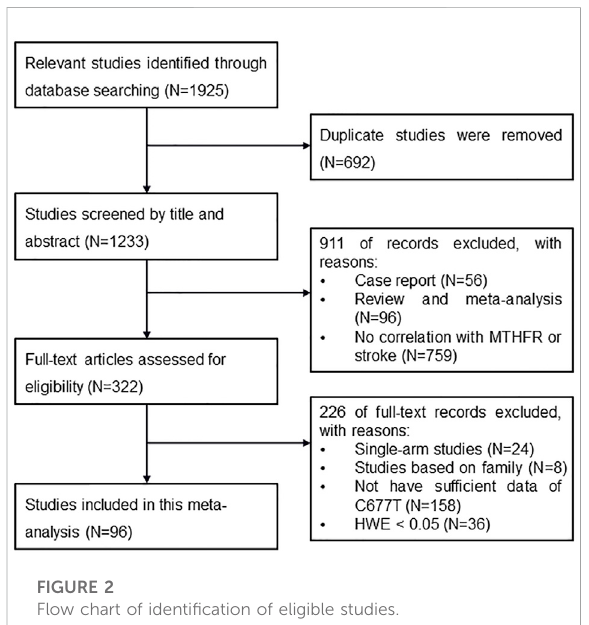
FIGURE 2 Flow chart of identi fi cation of eligible